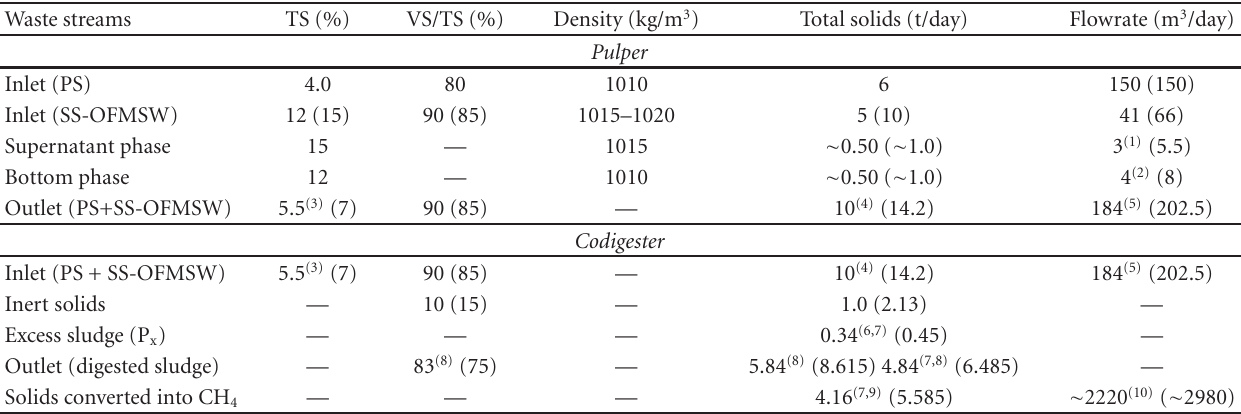
= 100gr/PE · day). SS-OFMSW